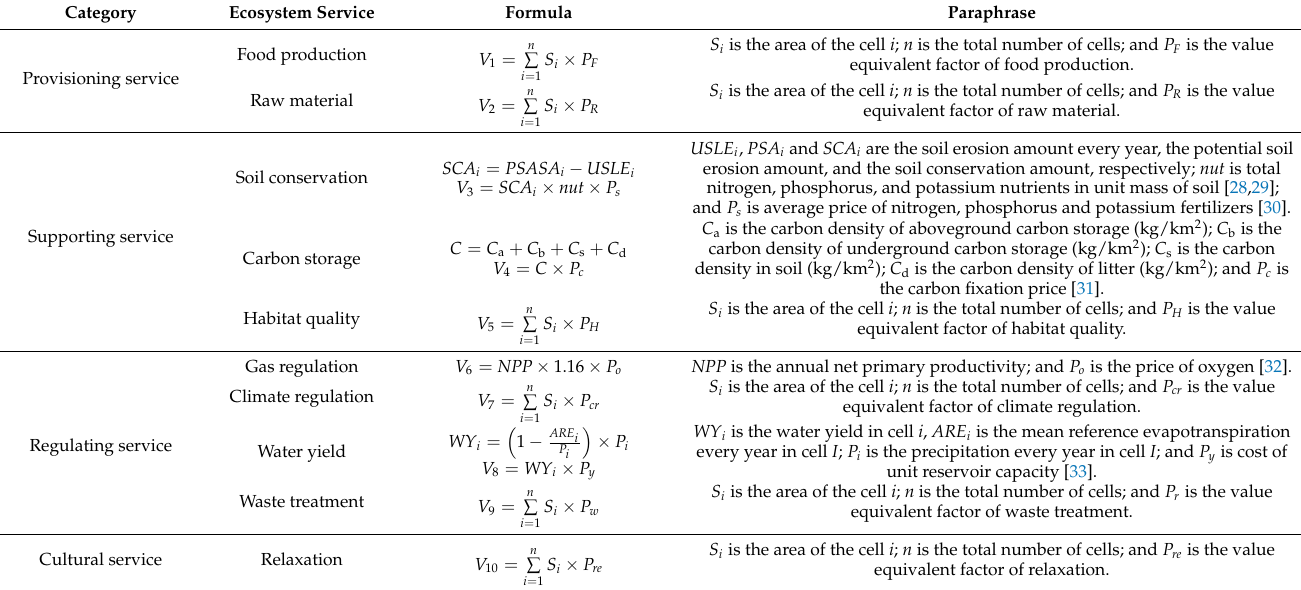
Table 2. Overview of ecosystem services assessed in this